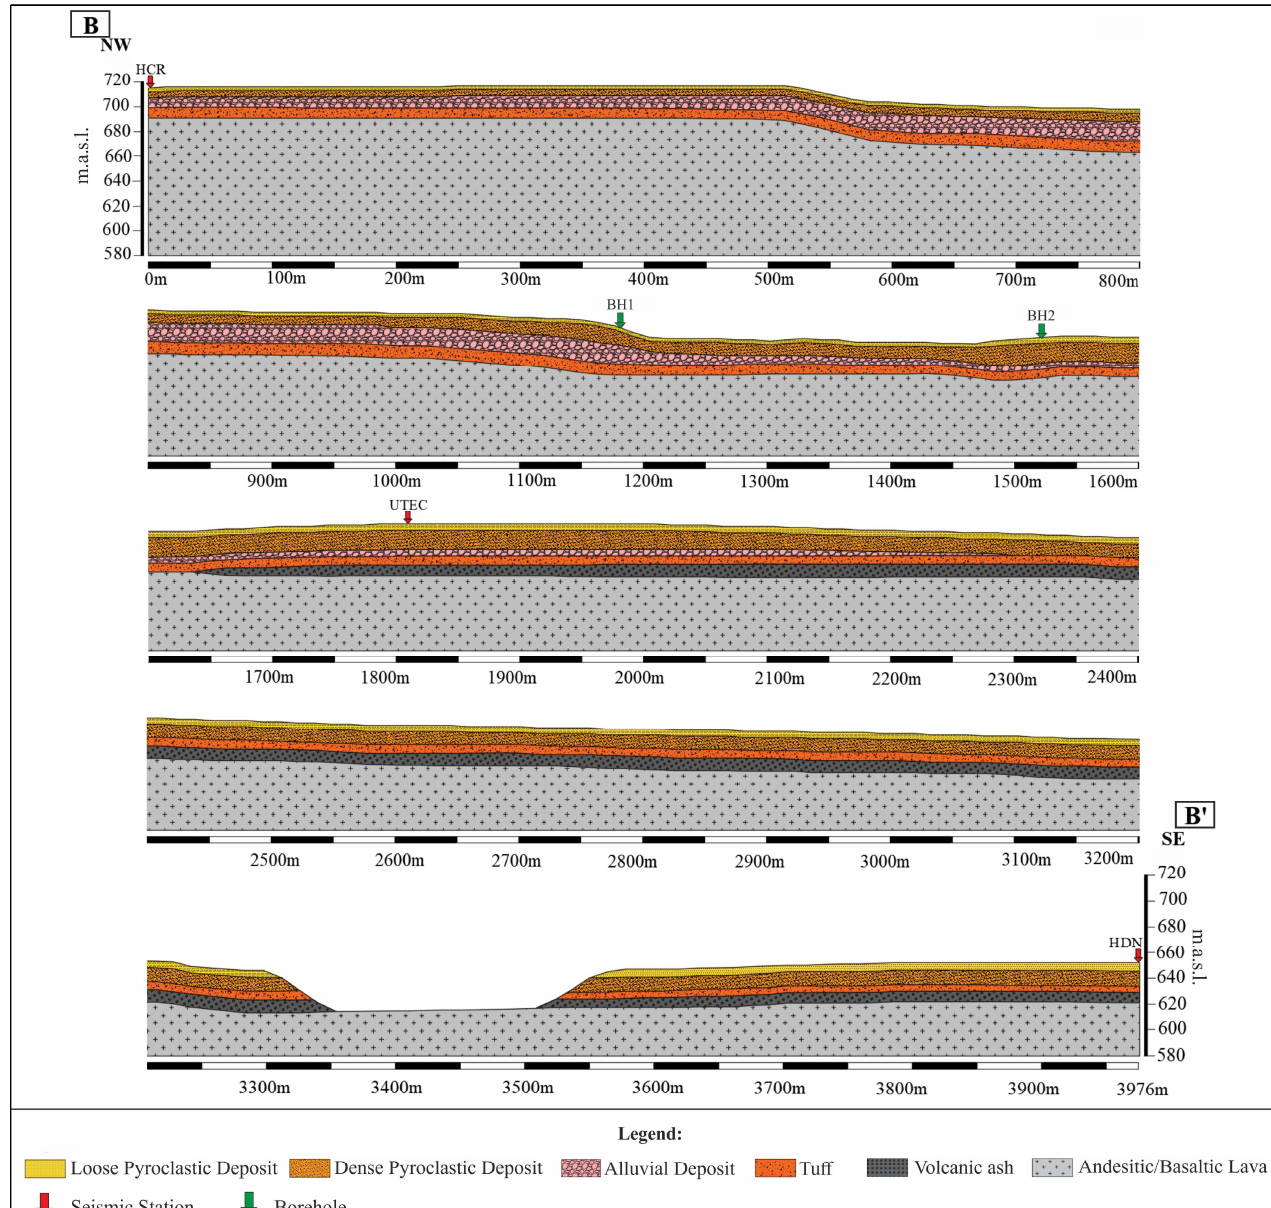
Figure 6. BB’ section of subsoil at MASS (see Figure 3). Figure 6. BB (cid:48) section of subsoil at MASS (see Figure